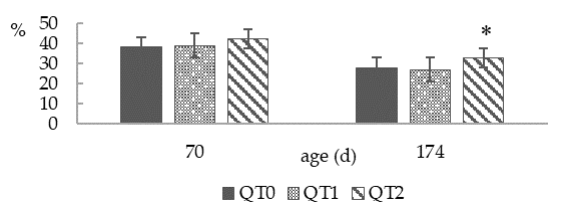
Figure 4. Dropping dry matter at two di ff erent ages from birds fed di ff erent levels of QT (mean ± SEM). * Indicates a di ff erence between treatment and QT0 (Dunnett’s t -test, p < 0.05). QT0 = basal diet; QT1 and QT2 = the basal diet supplemented with QT at 1% and 2%, respectively.